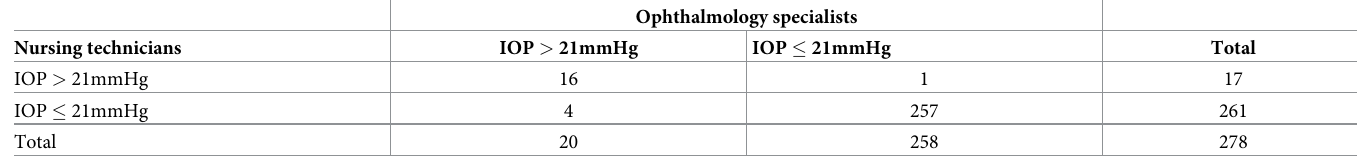
Table 3. Diagnostic properties of assessment of intraocular pressure measured by doctor (gold standard) and nursing